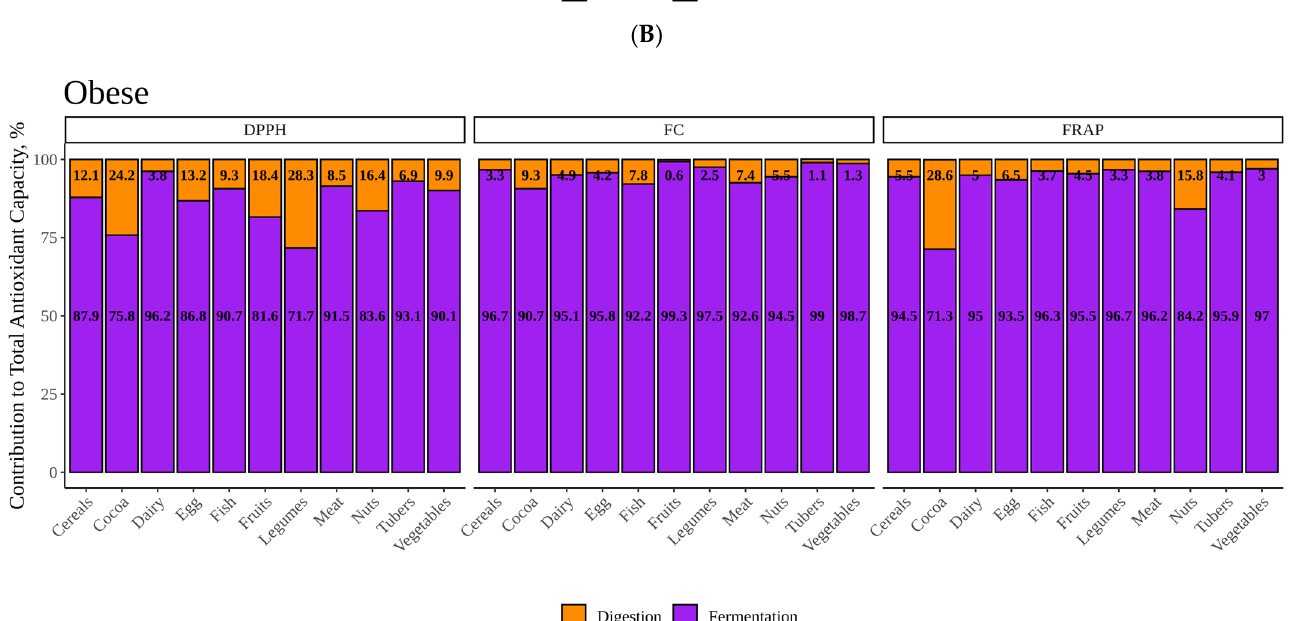
Figure 8. Contribution to the total antioxidant capacity of the fractions obtained after in vitro di- gestion and fermentation for lean and obese. ( A ) Contributions fermenting with fecal material from lean children. ( B ) Contributions fermenting with fecal material from obese children.